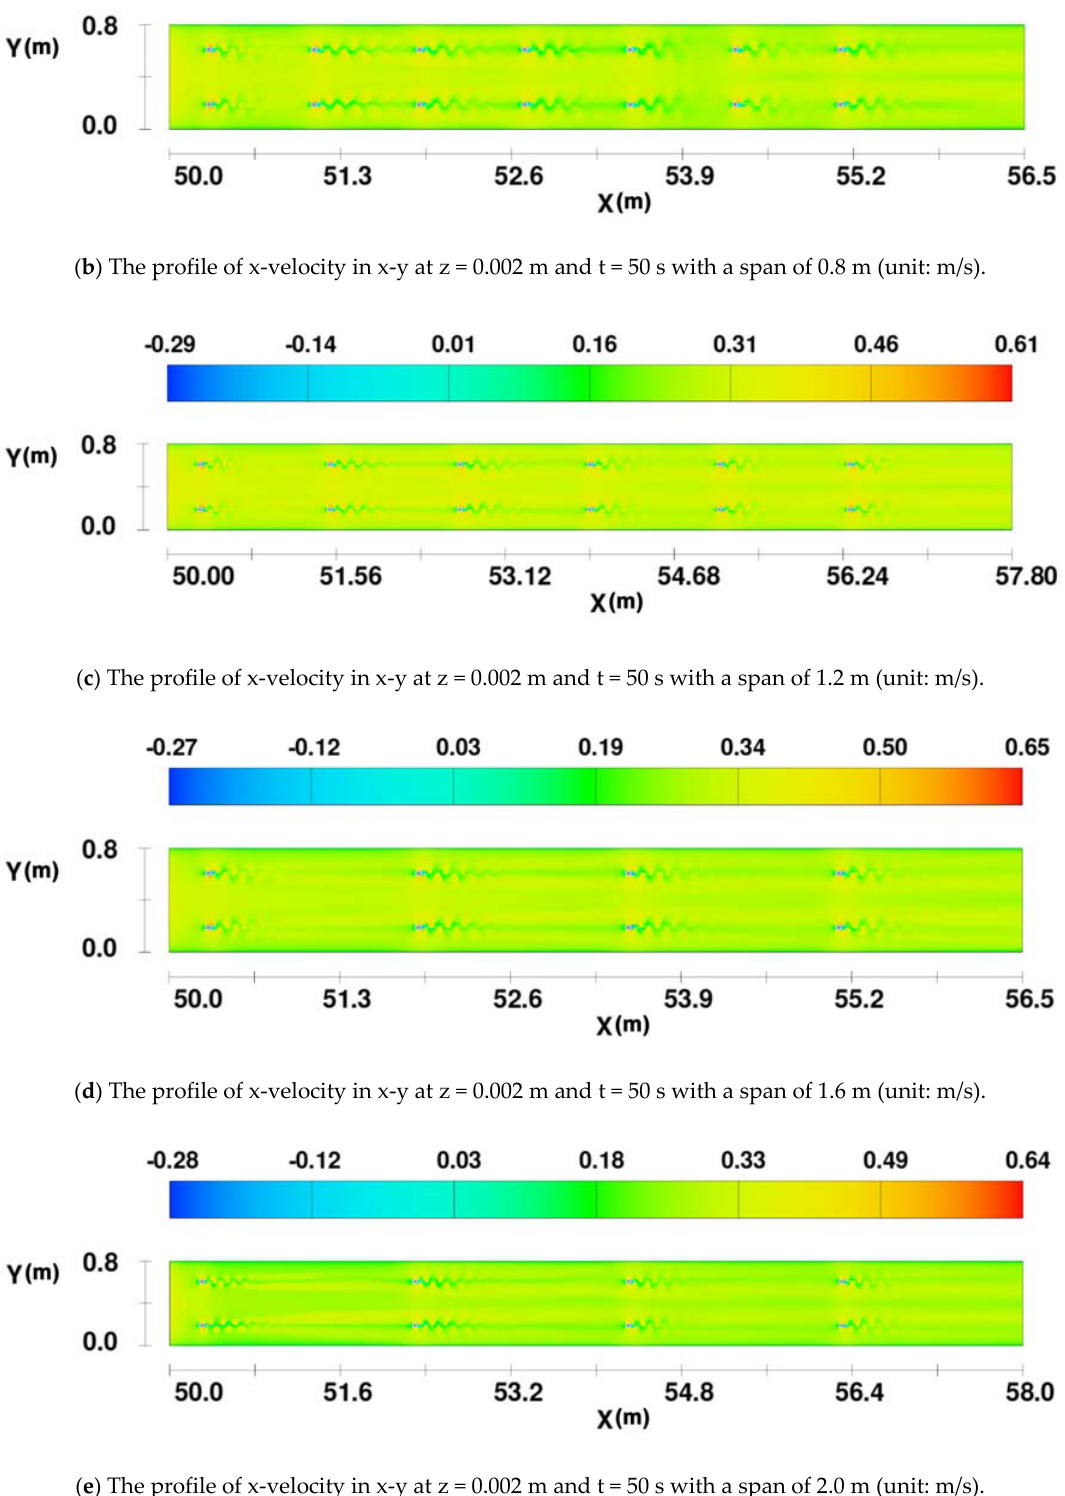
Figure 10. The profile of x ‐ velocity in x ‐ y at z = 0.002 m and t = 50 s with different spans. 222 The accumulative influence of the superposition of the Kármán Vortex Streets on the x ‐ 223 velocity was observed when the span was shorter than 27.5D, as shown in Figure 10(a) and (b). 224